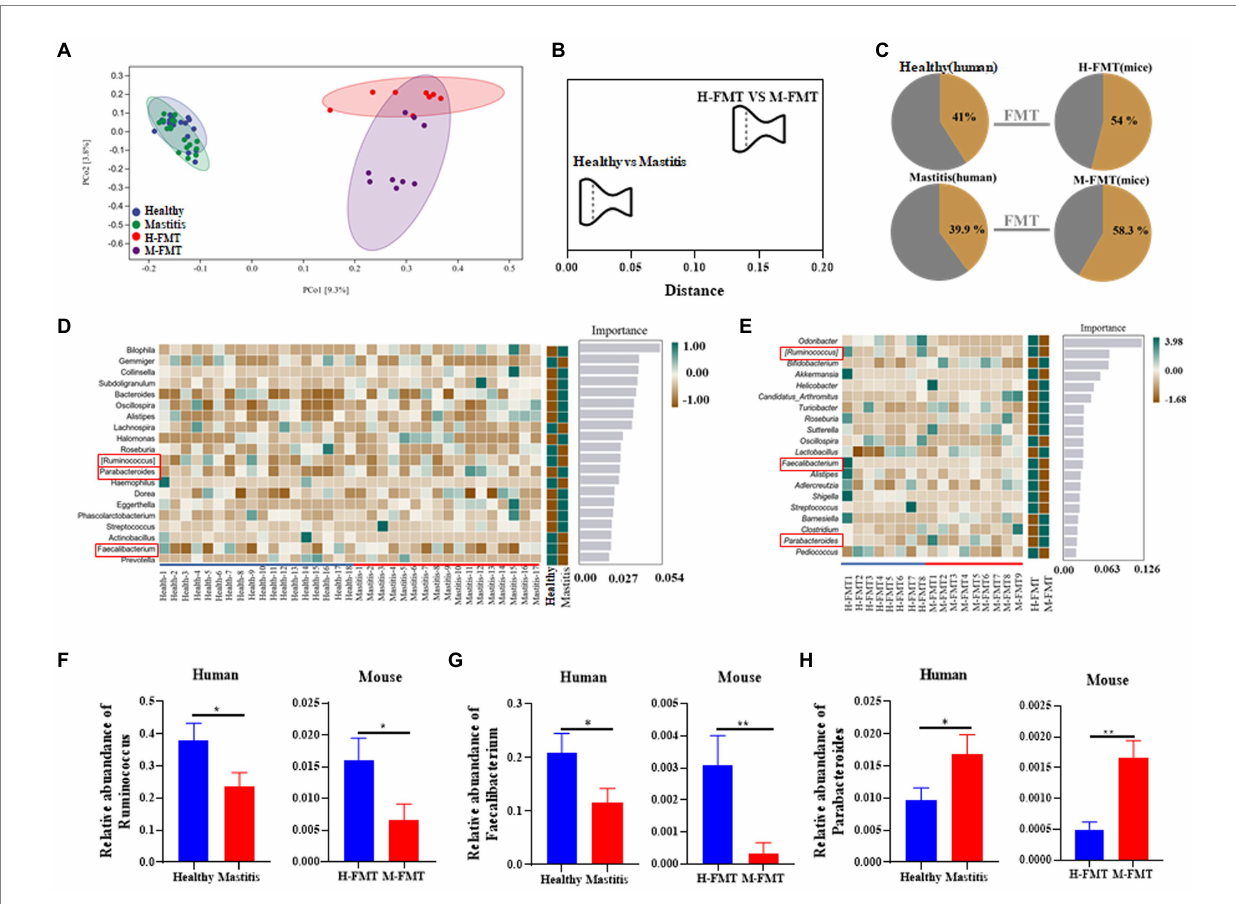
FIGURE 5 Comparison of mastitis-associated microbiota in humans and those in the mouse. PCoA clustering (A) and relative similarity (B) of person and mice microbiota based on organismal structure ( via Meta-Storm distance) were shown. (C) Unique and shared OTUs before and after FMT in person and mice. (D) Random Forest (RF) classification of genus-level gut microbiota in two groups of volunteers. (E) Random Forest (RF) classification of gut microbiota in two groups of recipient mice. (F–H) Relative abundances of Ruminococcus , Faecalibacterium , and Parabacteroides between the human and mouse groups. n = 8–15 person or mice per group. * p < 0.05 by t